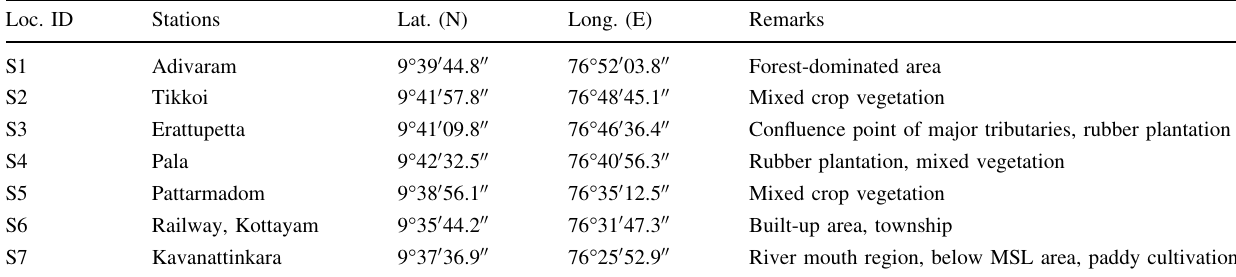
Table 1 Portrait of sampling stations Loc. ID